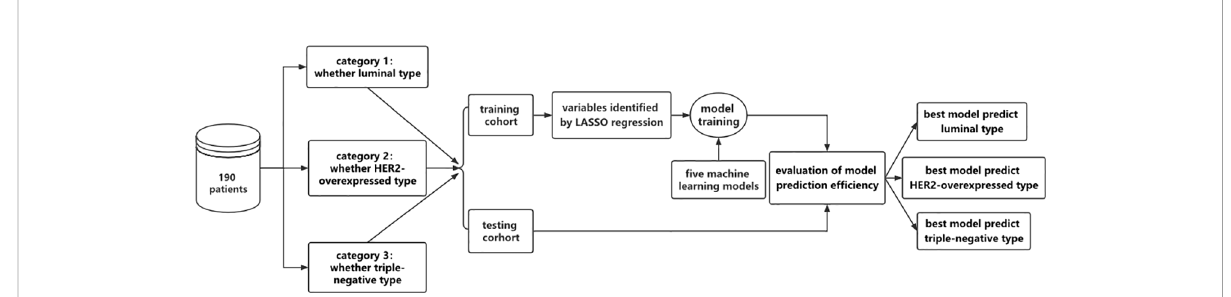
FIGURE 3 Flow chart of model establishment in this study. The 190 patients were grouped according to different molecular pressure types and divided into 3 categories, namely luminal and non-luminal, HER2-overexpressed and non-HER2-overexpressed, triple negative and non-triple negative. The following data were divided into training dataset and testing dataset. In the training dataset, the feature variables were screened by LASSO regression, and fi ve machine learning models were used to construct the model. The performance evaluation of the model was carried out in the testing dataset to determine the optimal